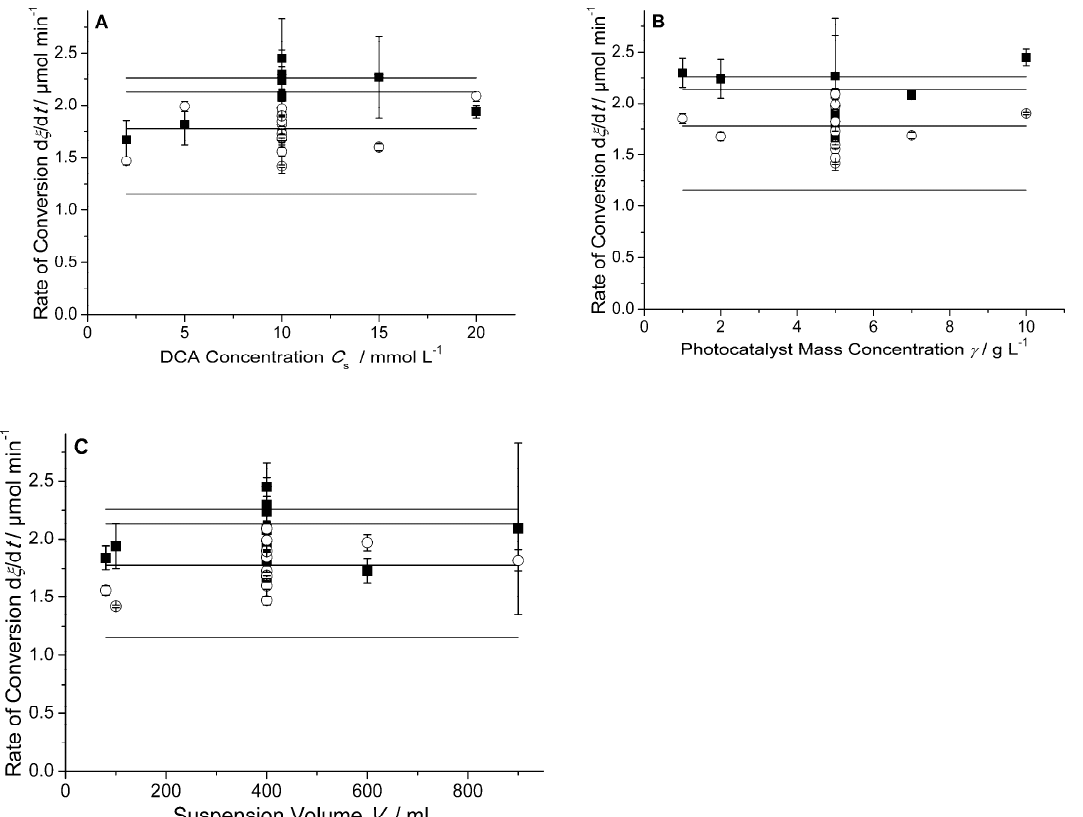
Figure 5. Rates of conversion d ξ (DCA)/dt and d ξ (Cl − )/dt vs. ( A ) the DCA concentration C s , ( B ) the photocatalyst mass concentration γ , and ( C ) the suspension volume V . The lines represent the limits of experimental errors (= mean rate ± standard deviation) for DCA ( ■ , thick lines) and Cl − ( ◯ , thin lines).